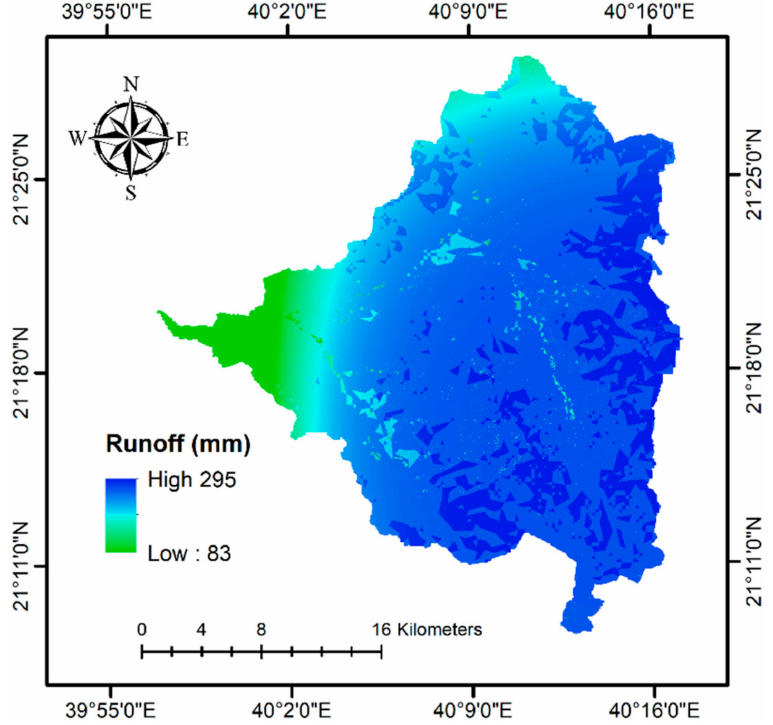
Figure 11. Runoff depth potential map in the study